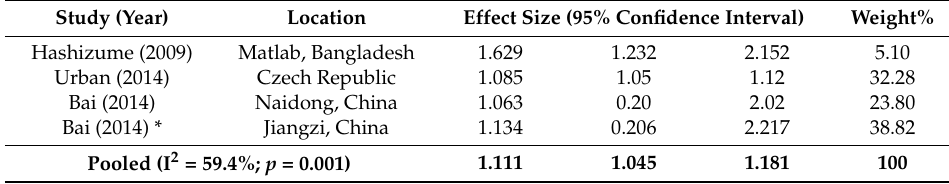
Figure 4. Meta-analysis results for studies using daily mean temperature for cardiovascular mortality. Table 3. Effect size estimates of studies using daily mean temperature for cardiovascular mortality.